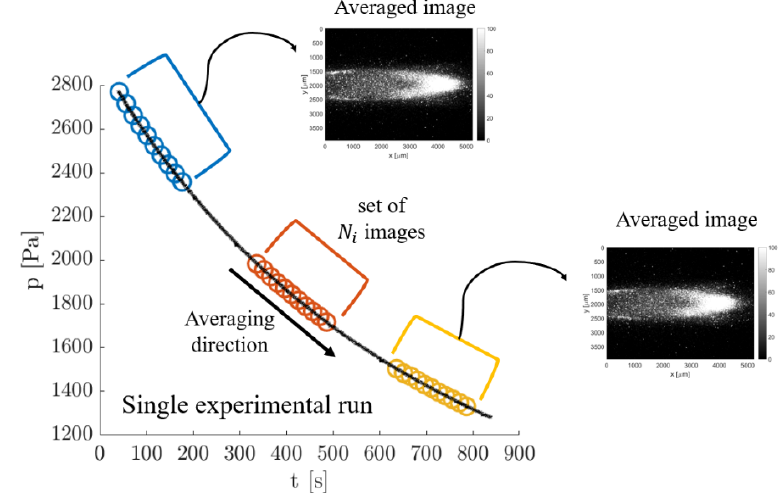
Figure 7. Qualitative illustration of the strategy used for producing an averaged image from a group of 𝑁 𝑖 images. The average is made “in cascade” on 𝑁 𝑖 images recorded during the same experimental run.